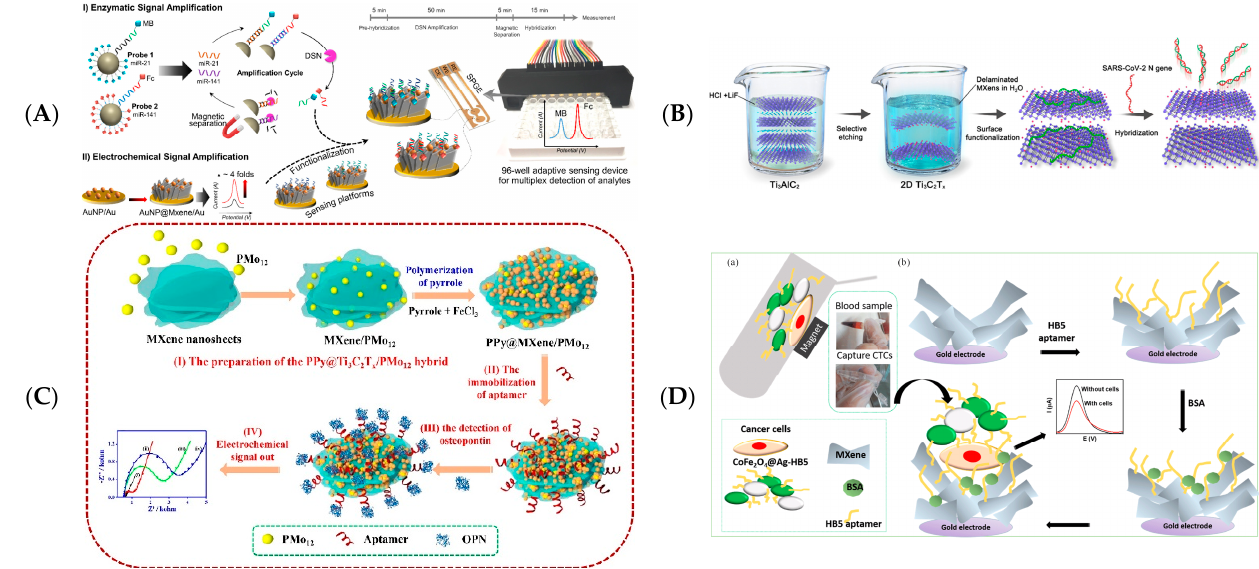
Figure 7. ( A ) Schematic diagram representing the entire assay procedure for multiplex and concurrent detections of miRNA. Reprinted with permission from Ref. [73]. Copyright 2020, Elsevier. ( B ) Schematic of the ssDNA/Ti 3 C 2 T x for the detection of the SARS − CoV − 2 nucleocapsid gene. Reprinted with permission from Ref. [74]. Copyright 2022, American Chemical Society. ( C ) Schematic diagram of PPy@Ti 3 C 2 /PMo 12 aptamer biosensor for OPN detection. Reprinted with permission from Ref. [64]. Copyright 2019, Elsevier. ( D ) Schematic diagram of the MXenes based cell sensor for the detection of SK − BR − 3 cells: magnetic cell separation using CoFe 2 O 4 @Ag − HB5 (a) and electrochemical cell detection on a functionalised MXenes surface (b). Adapted with permission from Ref. [77]. Copyright 2021, Elsevier.